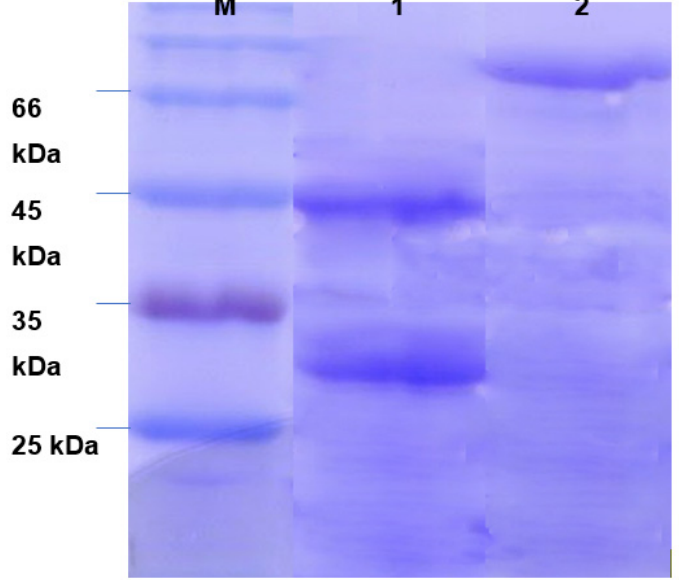
Figure 7. SDS-PAGE analysis of the crude extracellular proteases and amylase from Bacillus sp. FW2. Lane M, molecular weight of marker standard; lane 1: the crude extracellular proteases; lane 2: the crude extractcellular amylases.